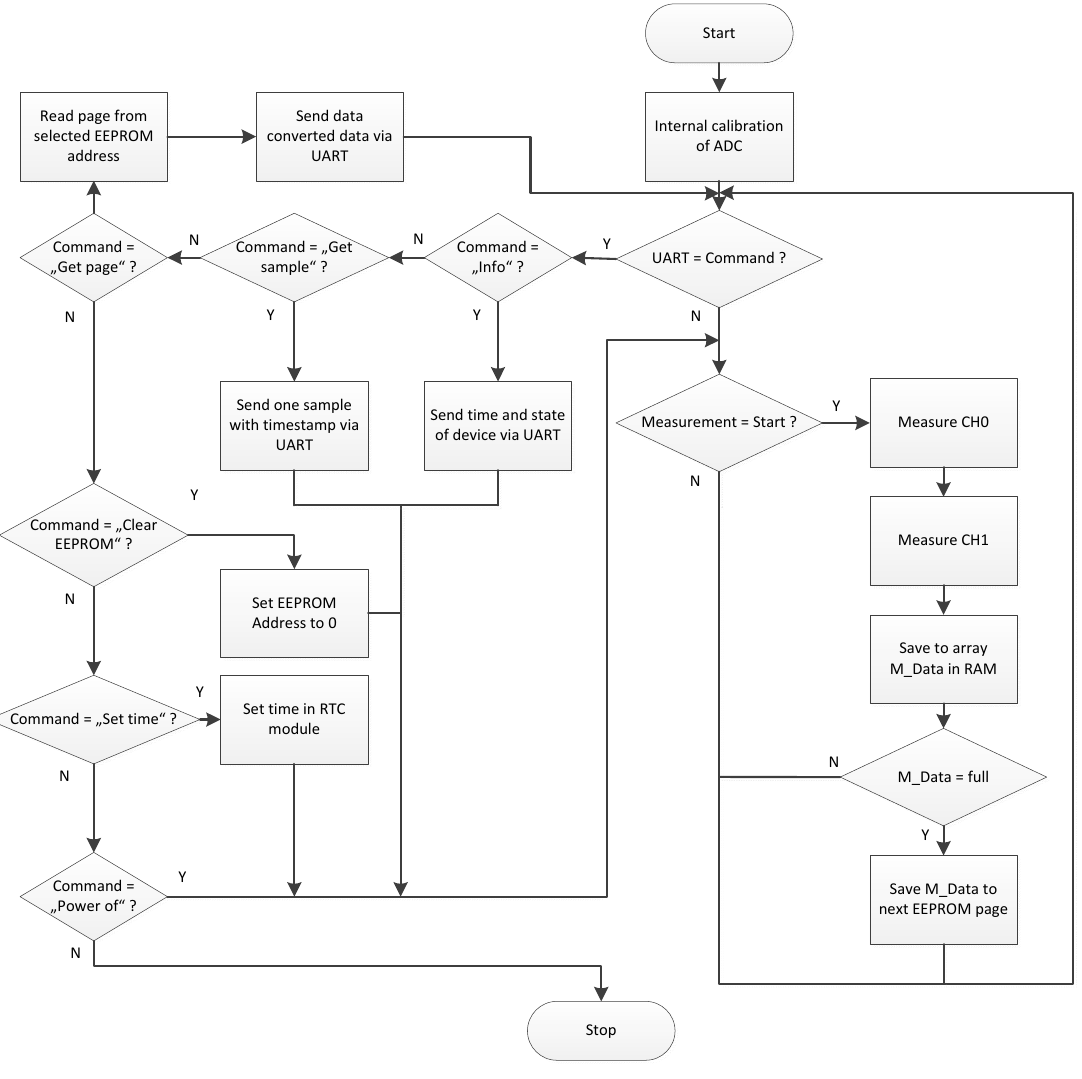
Figure 11. Flow chart of the proposed software.